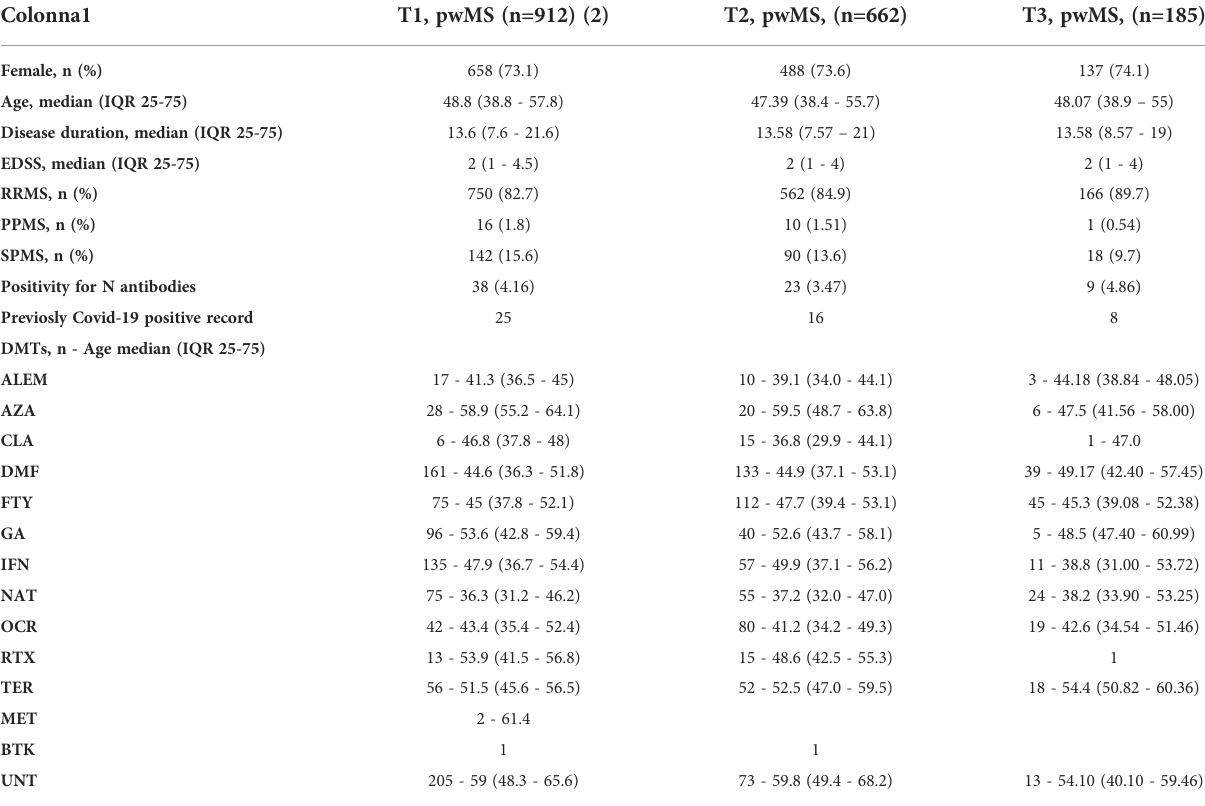
pwMS, multiple sclerosis patients; RRMS, relapsing-remitting multiple sclerosis; PPMS, primary progressive multiple sclerosis; SPMS, secondary progressive multiple sclerosis; EDSS, Expanded Disability Status Scale; IQR, interquartile range DMT,disease modifying therapy; UNT,untreated; ALEM,alemtuzumab; IFN,interferon; GA,glatiramer acetate;